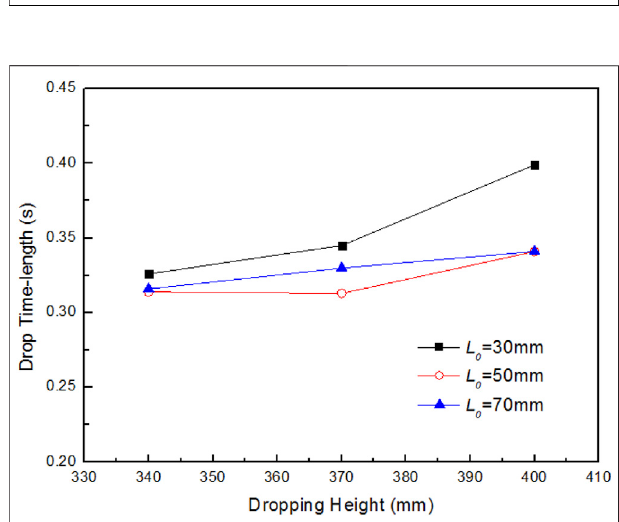
FIGURE 17 | The effects of dropping height on the drop time-length under different piston